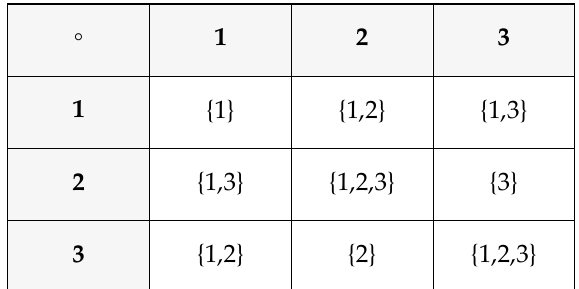
Table 5. Left almost-hypergroup.